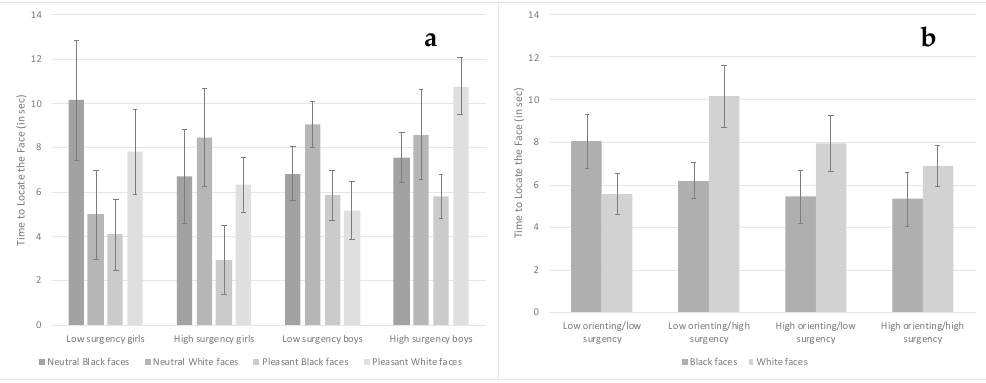
Figure 11. The time it took to locate faces based on infant surgency and gender and face race and expression (( a )—left chart) and based on infant orienting and surgency and face race (( b )—right chart). Bars represent standard error.